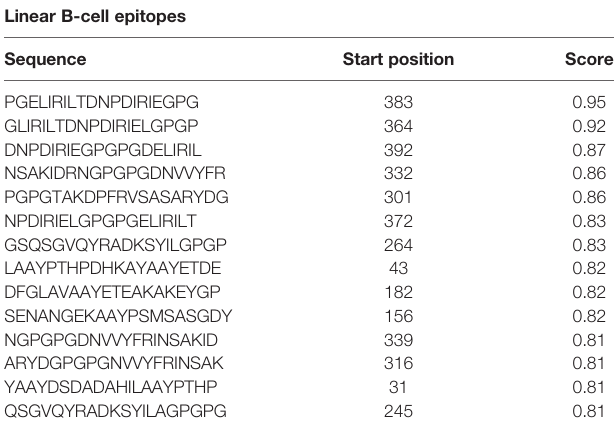
TABLE 4 | Predicted linear B-cell